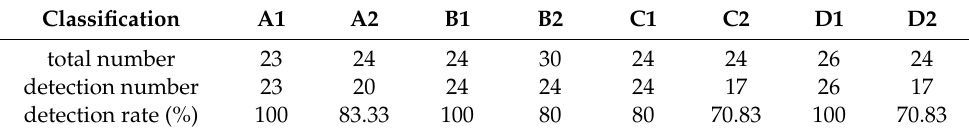
Table 8. Qualitative discrimination results of di ff erent concentrations based on the improved algorithm.